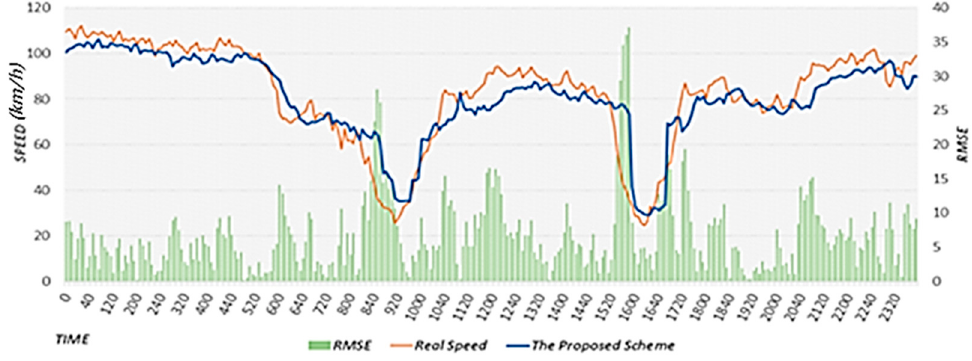
Figure 21. Results of predicting the road speed using the proposed scheme.